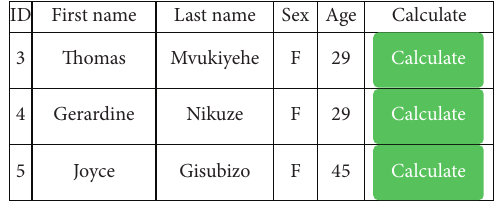
Figure 10: View of the list of patients and calculation of results by a medical doctor.